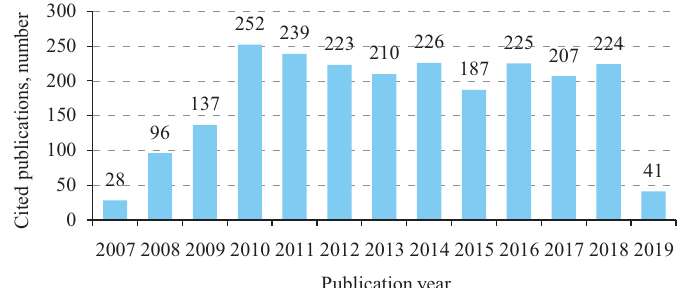
Figure 3. Distribution of the publication citations of the Baltic Journal of Road and Bridge Engineering between 2007 and